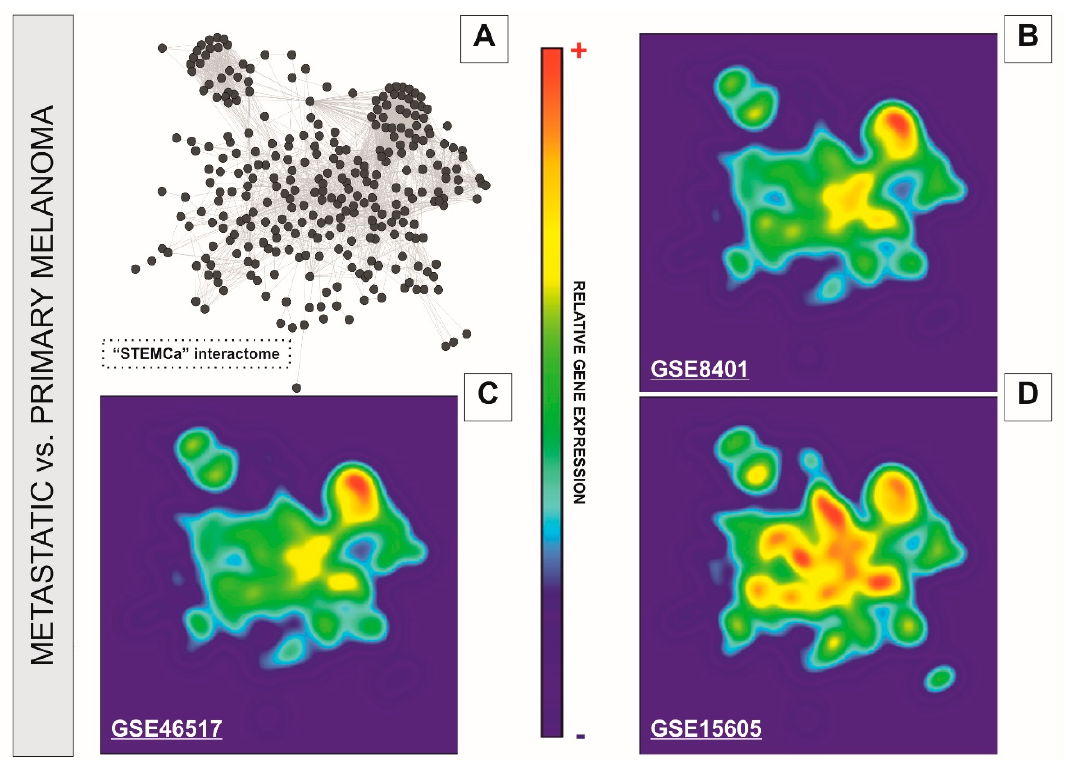
Figure 3. GALANT plots over the in silico model “STEMCa” in melanoma metastasis from three independent sample sources from GEO. The figure represents the relative gene expression over the “STEMCa” interactome ( A ) in melanoma metastasis vs. primary melanoma analyzed in ( B ) GSE8401, ( C ) GSE46517, and ( D ) GSE15605 independent microarray samples, by using the GALANT software, which is an open-source application able to build landscape maps of gene expression networks.